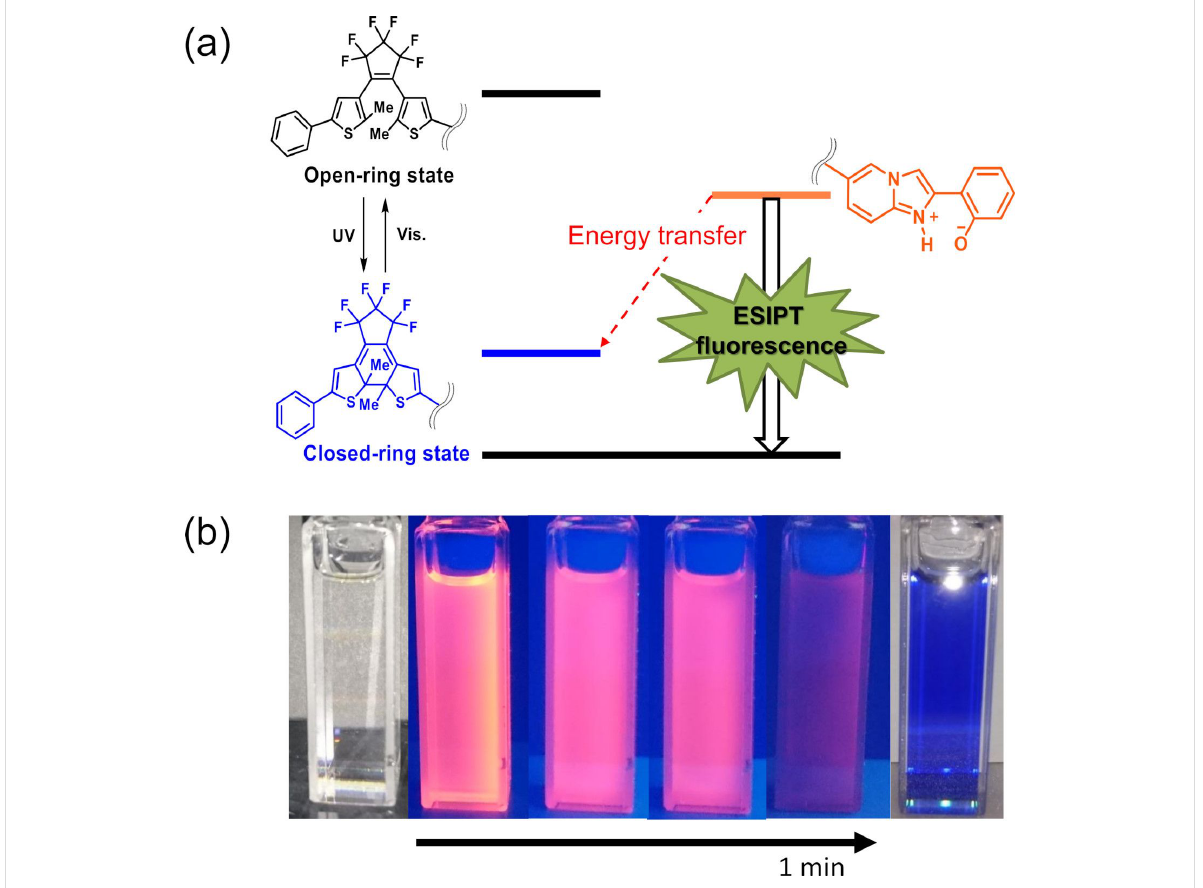
Figure 5: (a) The energy diagram of the ESIPT process of 1 . (b) ESIPT fluorescence quenching upon UV light ( λ = 313 nm) irradiation of 1o in THF solution. The fluorescence is quenched by photo-generated closed-ring isomer 1c .